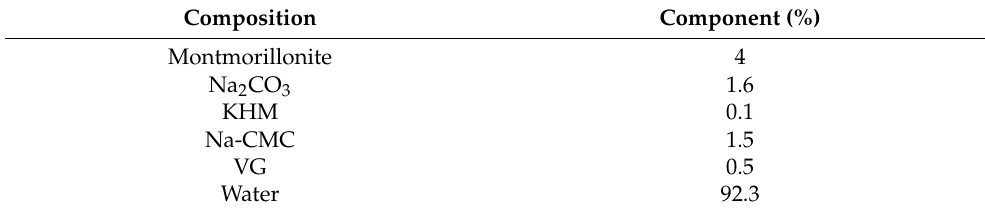
Table 2. Composition of drilling fluid.